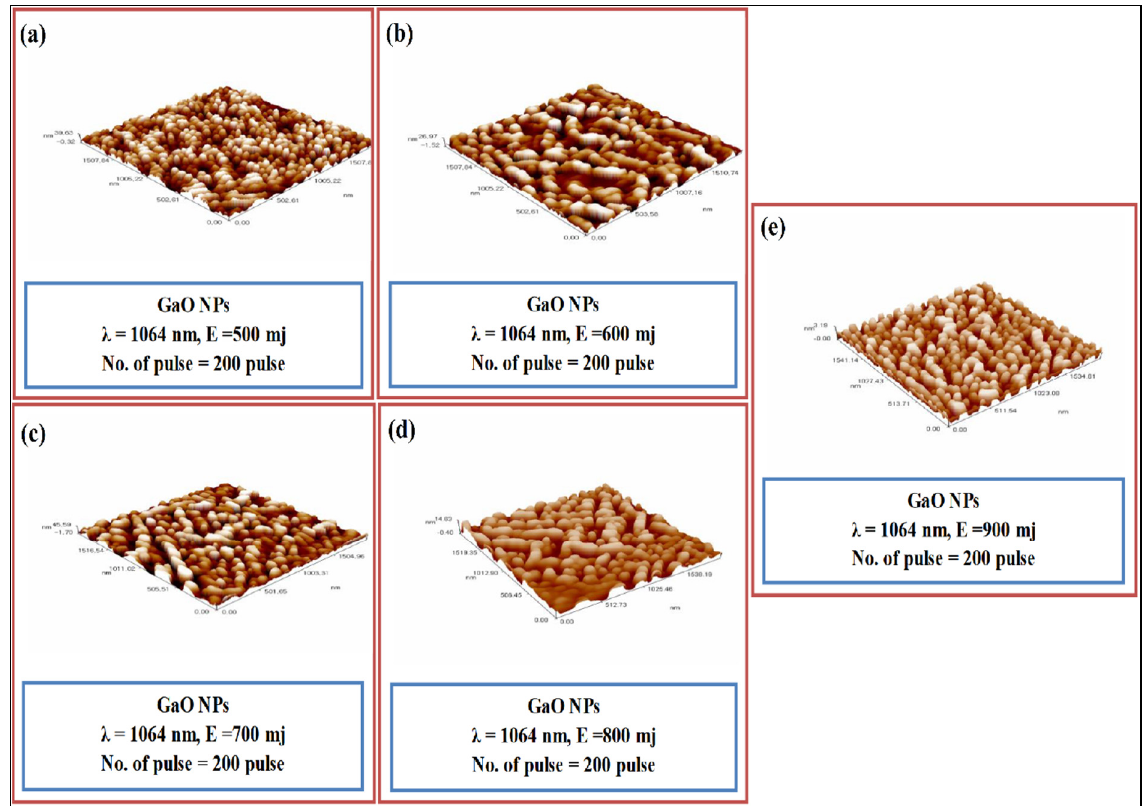
Figure 8. The AFM of the nanoparticles produced by pulsed laser deposition. ( a ) 500 mJ; ( b ) 600 mJ; ( c ) 700 mJ; ( d ) 800 mJ; ( e ) 900 mJ [141]. “Reprinted with permission from Ref. [141]. Copyright (2020), College of Science, University of Baghdad”.